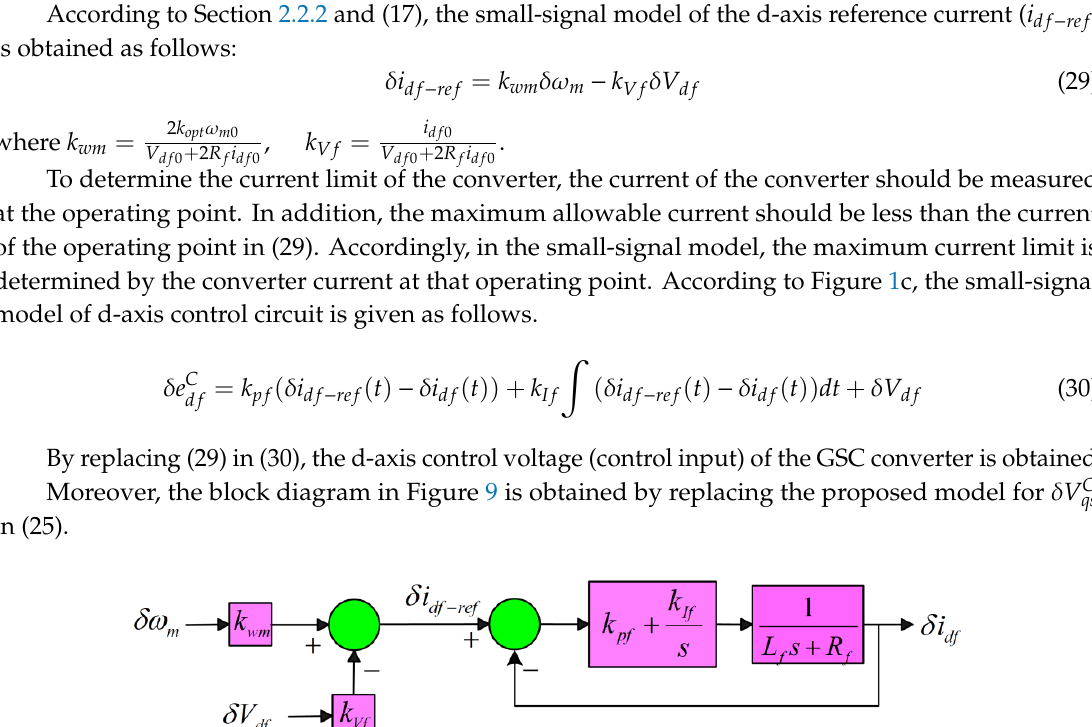
Figure 9. Small-signal block diagram of the grid-side controller.